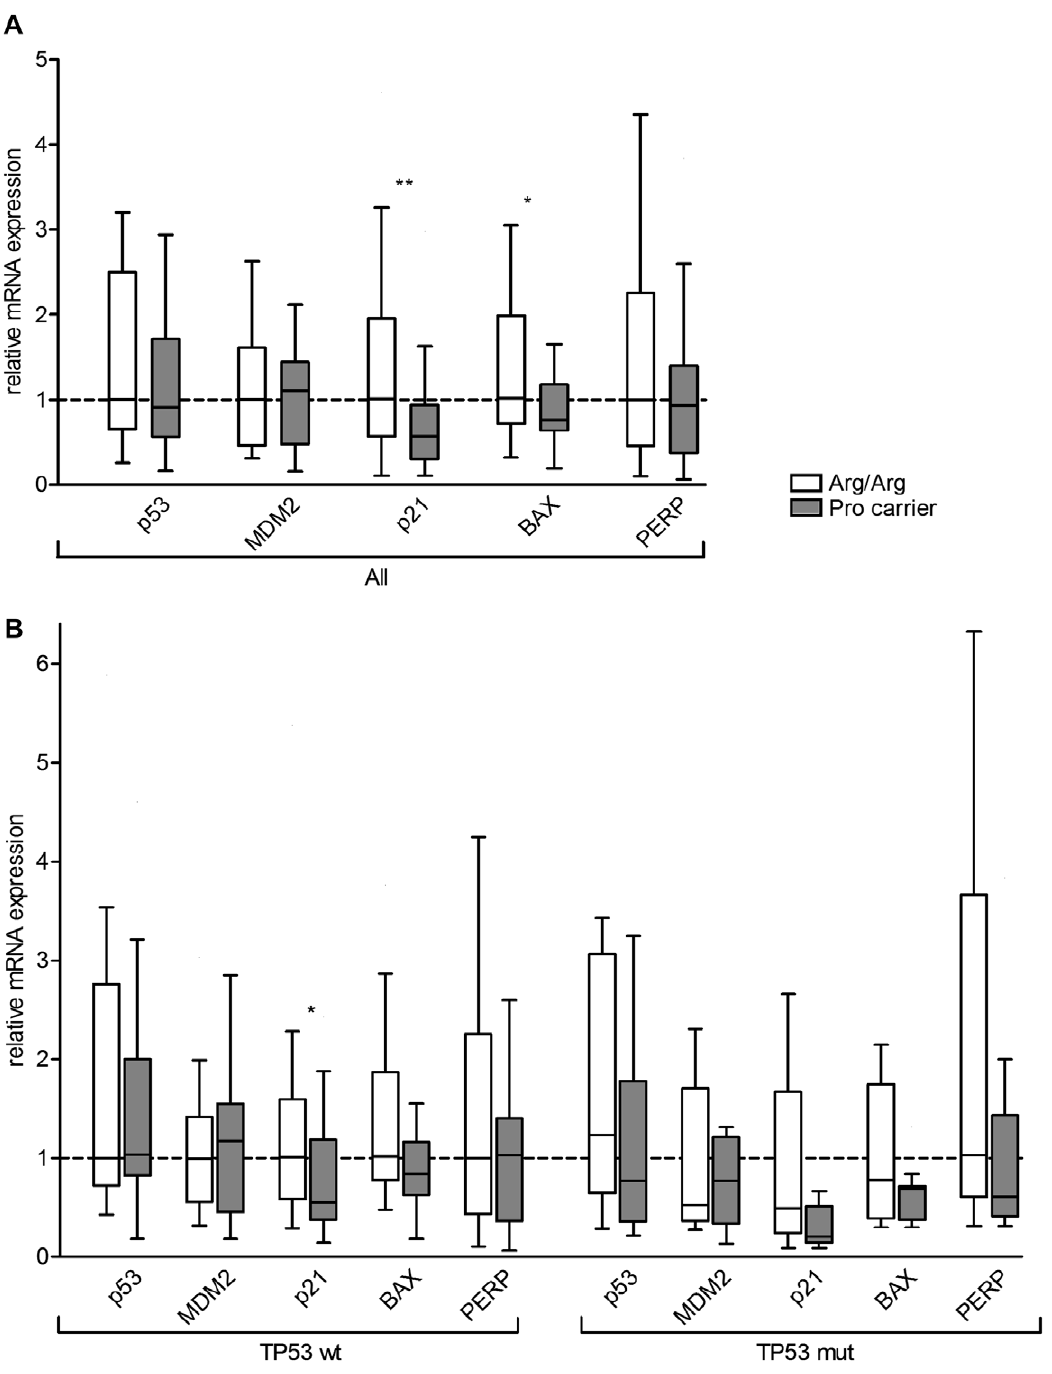
Figure 2. Expression of p53 target genes in human breast tumors. Boxplots of the intratumoral p53, MDM2, p21, BAX and PERP mRNA levels of breast cancer patients, normalized to b -actin. A, Results for unselected patients with genotype Arg/Arg (n=36) and Pro-allele carriers (n=37). Median mRNA expression levels of Arg/Arg patients were set to 1, and median levels of Pro-allele carriers (Arg/Pro, Pro/Pro) are expressed relative to the levels of Arg/Arg patients. B, Results for patients with TP53 wildtype (wt) tumors with genotype Arg/Arg (n=24) and for Pro-allele carriers (n=25), and patients with TP53 mutated (mut) tumors with genotype Arg/Arg (n=12) and for Pro-allele carriers (n=12). Median mRNA expression levels of Arg/Arg patients with wildtype p53 were set to unity, and the levels of Arg/Arg patients with mutant p53, and of Pro-carriers with wildtype or mutant p53 are expressed relative to those. **indicates p-values , 0.01; *indicates p-values , 0.05 (Wilcoxon-Mann-Whitney U-Test). doi:10.1371/journal.pone.0047325.g002 this exploratory analysis, higher odds ratios were determined in with the Pro-allele were significantly elevated in ER positive, PR patients with a lobular tumor type, and in patients with a low- positive, and in HER2 negative patients (Table 3). Importantly, grade tumor (pG1 or 2 vs. pG3). Moreover, odds ratios associated the impact of the Arg72Pro SNP on breast cancer risk appears to